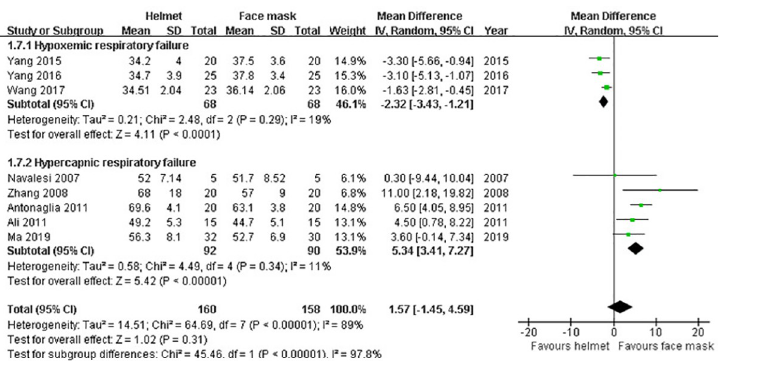
Fig 10. Forest plot of PaCO 2